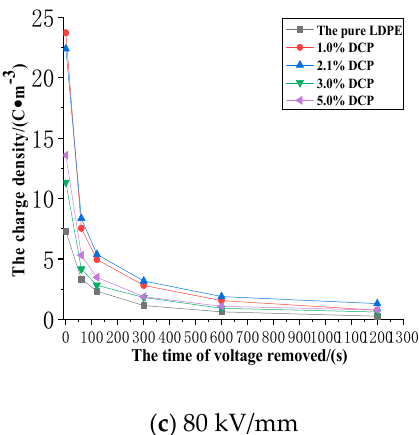
Figure 11. The average charge density of each unaged sample in the removed voltage experiment of different electric field strengths with the time of voltage application. ( a ) The experimental results at the electrical field strength of 30 kV/mm. ( b ) The experimental results at the electrical field strength of 50 kV/mm. ( c ) The experimental results at the electrical field strength of 80 kV/mm.